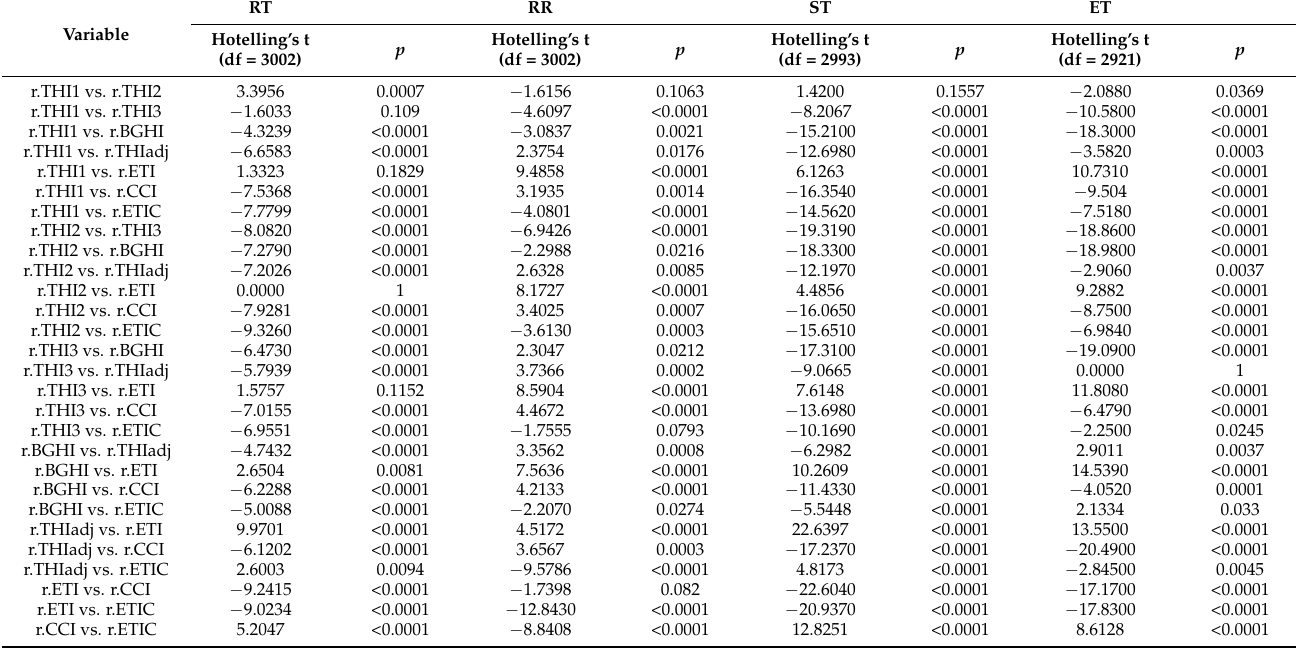
Table 4. Comparison of correlations with rectal temperature (RT), respiration rate (RR), skin temperature (ST), and eye temperature